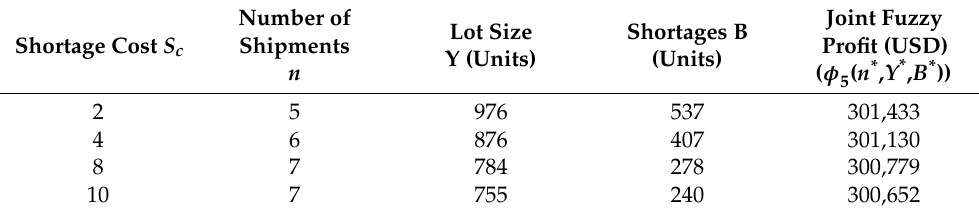
Table 11. Impact of the shortage cost on the decision variables and joint fuzzy profit.